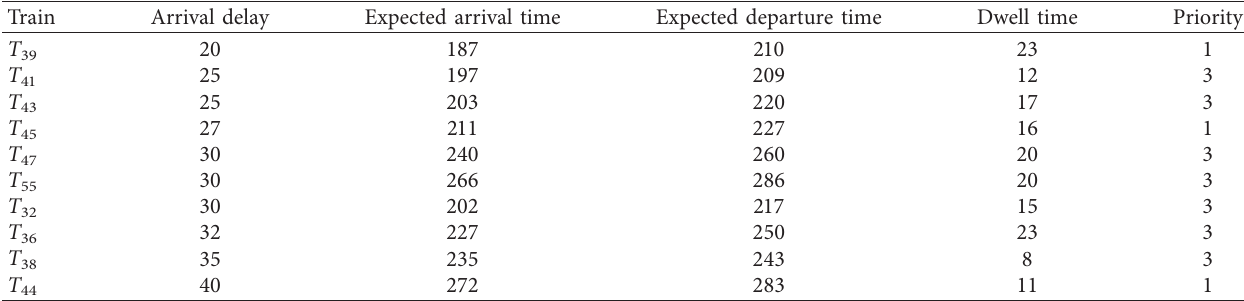
Table 6: Estimated arrival and departure times for delayed trains.